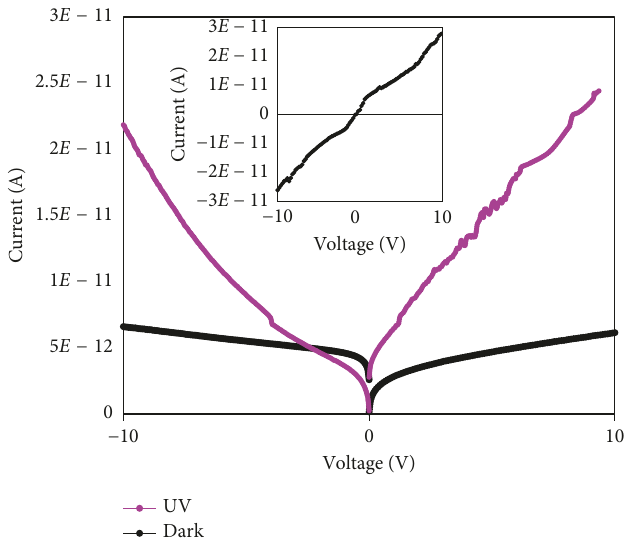
Figure 8: Dark current and photocurrent measured under 245nm UV illumination. The inset figure shows I-V characteristics measured using SMU1 as “Force” at positive and as “Ground” at negative voltages.